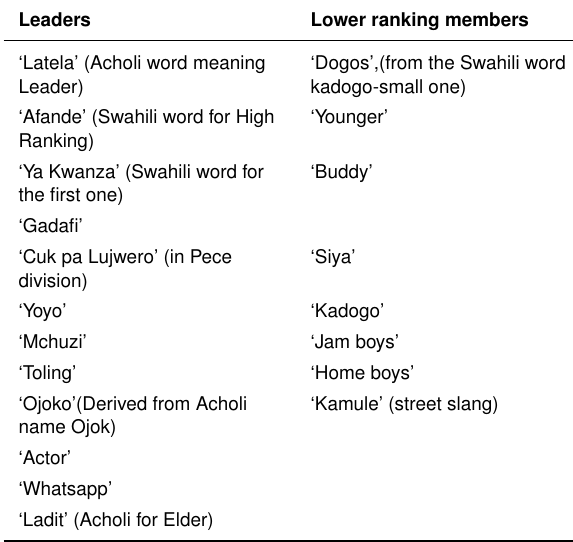
Table 2. Example of nicknames given to Aguu leaders and